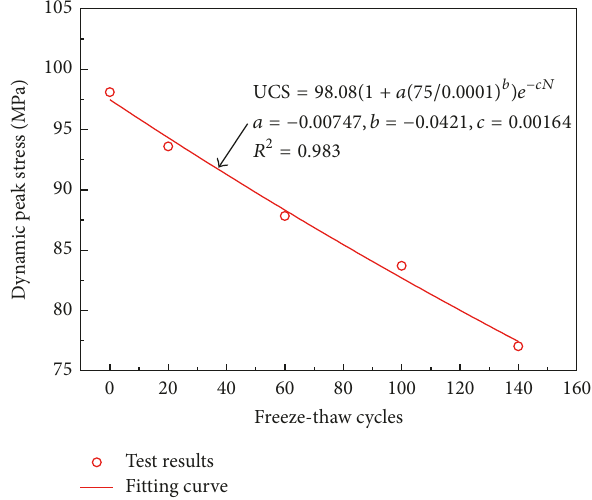
Figure 8: Relationship between dynamic peak stress and number of freeze-thaw cycles.